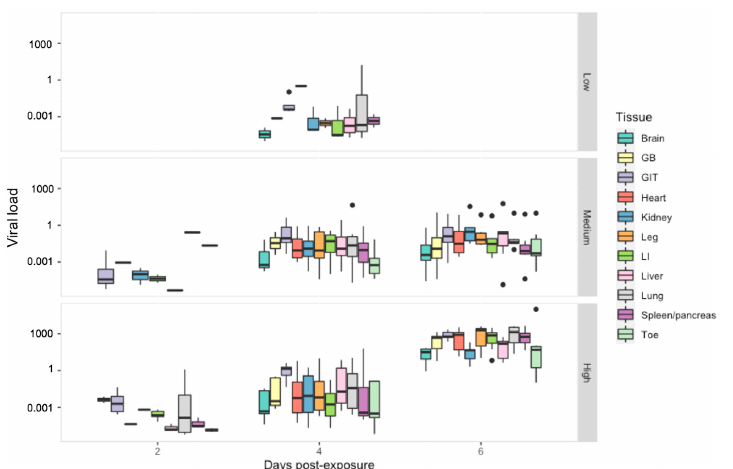
Figure 5. Viral load per host cell for tissue harvested from R. temporaria including: brain, gall bladder (GB), gastro-intestinal tract (GIT), heart, kidney, leg, large intestine (LI), liver, lung, spleen/pancreas and toe. Viral load is shown here in log10 scale. Black dots indicate outliers.